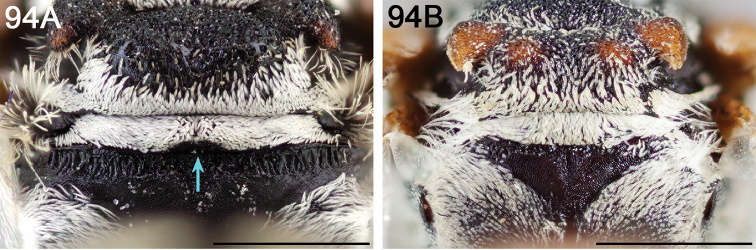
Metanotum (in posterior view) of female A
E.
axillaris holotype, which has a distinct posteromedial depression, and B
E.
attenboroughi paratype, which does not have a depression and is flat. Scale bars 1 mm.